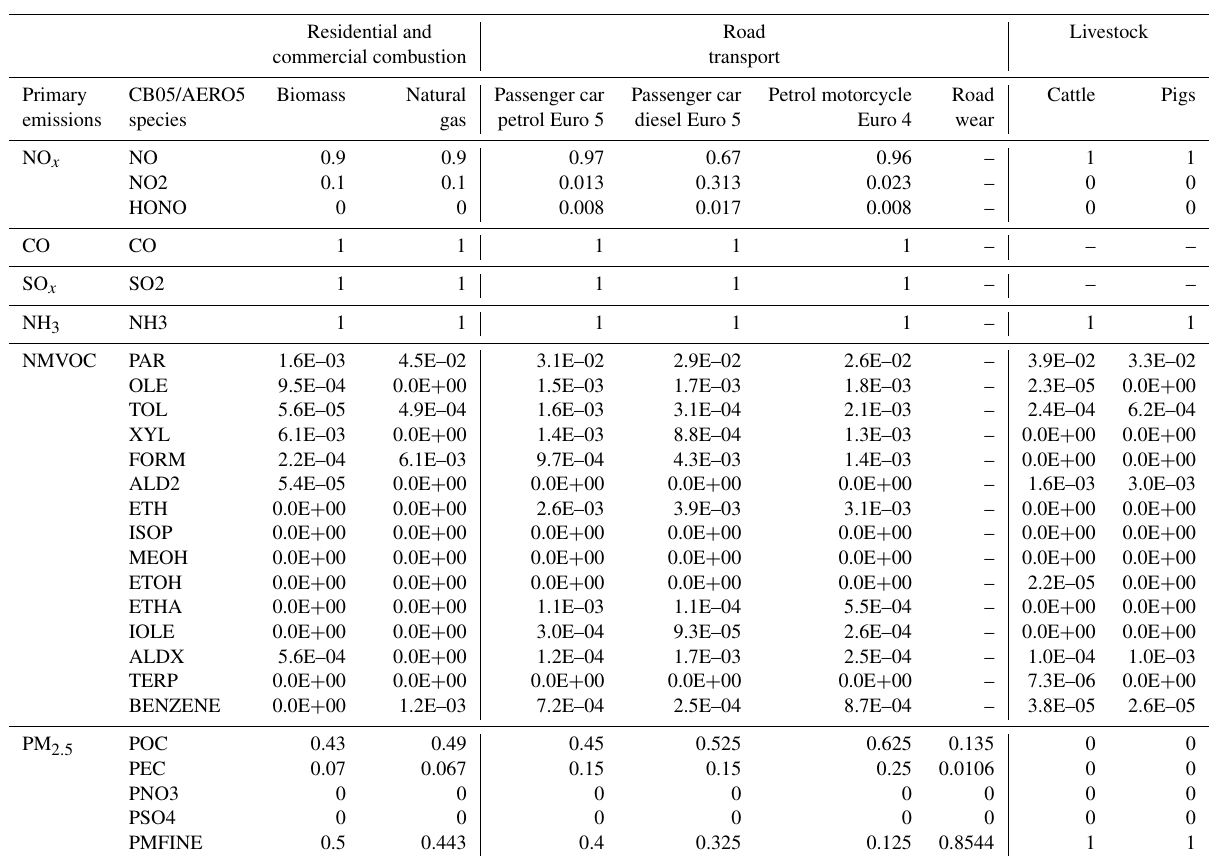
Table 2. Example of speciation profiles included in HERMESv3_BU for speciating primary emissions to CB05 and AERO5 mechanisms. Different pollutant sectors and categories are shown to illustrate the degree of specificity allowed by the model. Speciation factors are mole- based (mol of chemical species per gram of source pollutant) for NMVOC and mass-based (grams of chemical species per gram of source pollutant) for NO x , CO, SO x , NH 3 and PM 2 . 5 . Symbol “–“ denotes that no primary emissions are considered for that pollutant. All CB05 and AERO5 species are defined in Table A2 of Guevara et al.